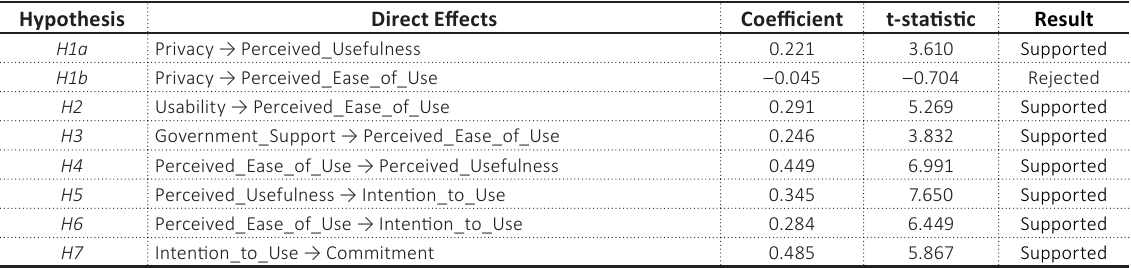
Table 7. SEM coefficients and direct effect checks